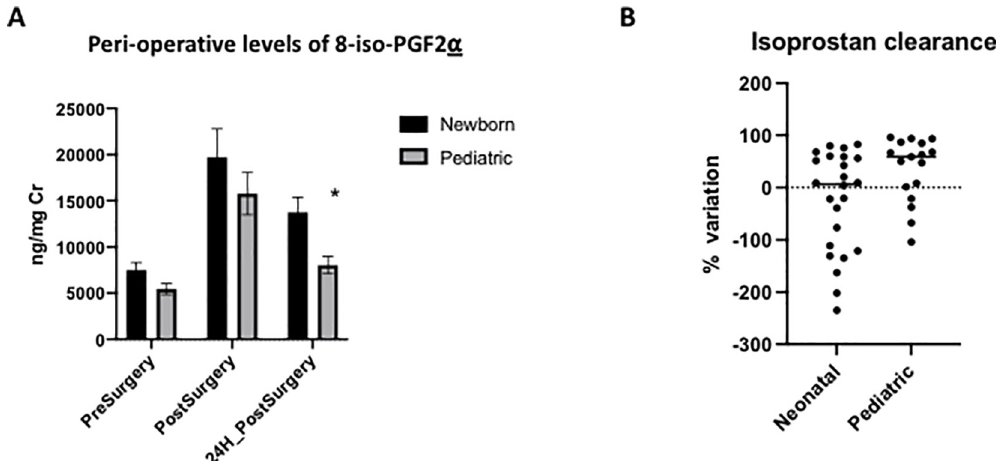
Fig 2. A: Peri-operative levels of 8-iso-PGF2 α across all three time points by subgroup (Expressed in ng/mg Cr and Mean +/s SD). B: Isoprostanes Clearance [(Post-surgery 8-iso-PGF2 α – 24 hours post-surgery 8-iso-PGF2 α ) � 100]/ Post-surgery 8-iso-PGF2 α . ( � p < 0.05).